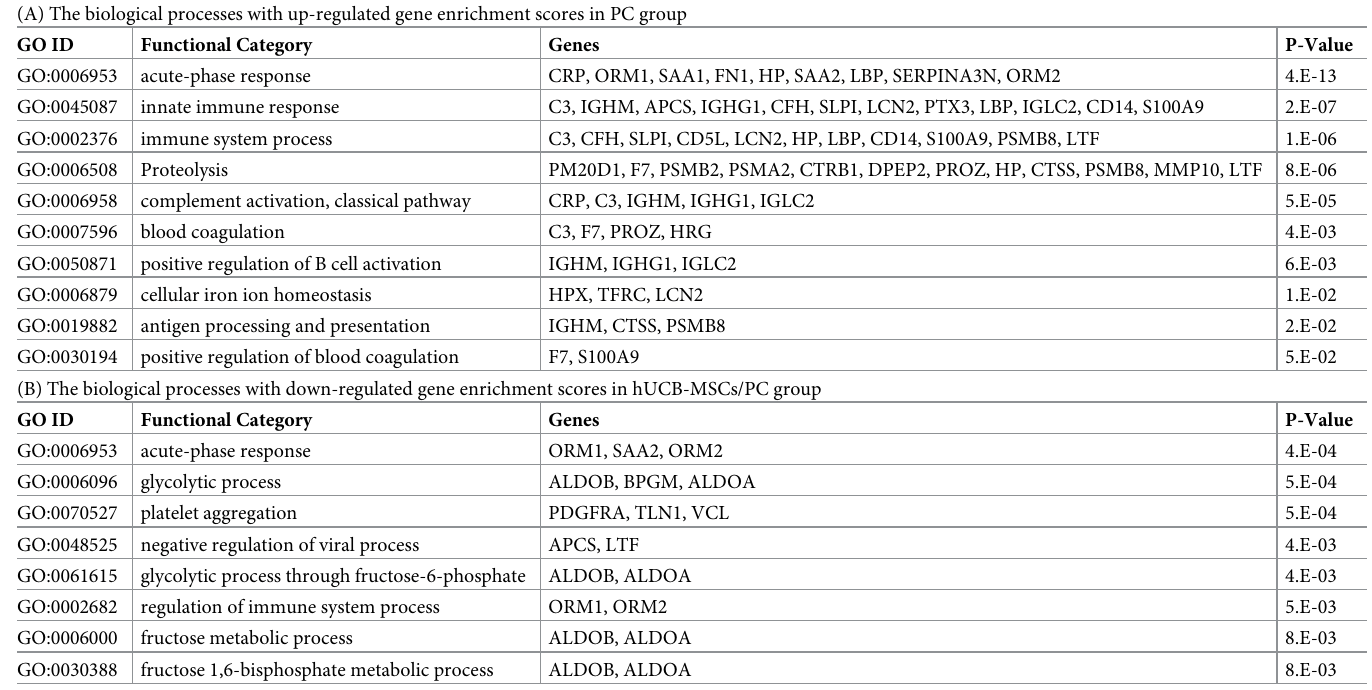
Table 1. Gene Ontology (GO) analysis of PC group and hUCB-MSCs group by